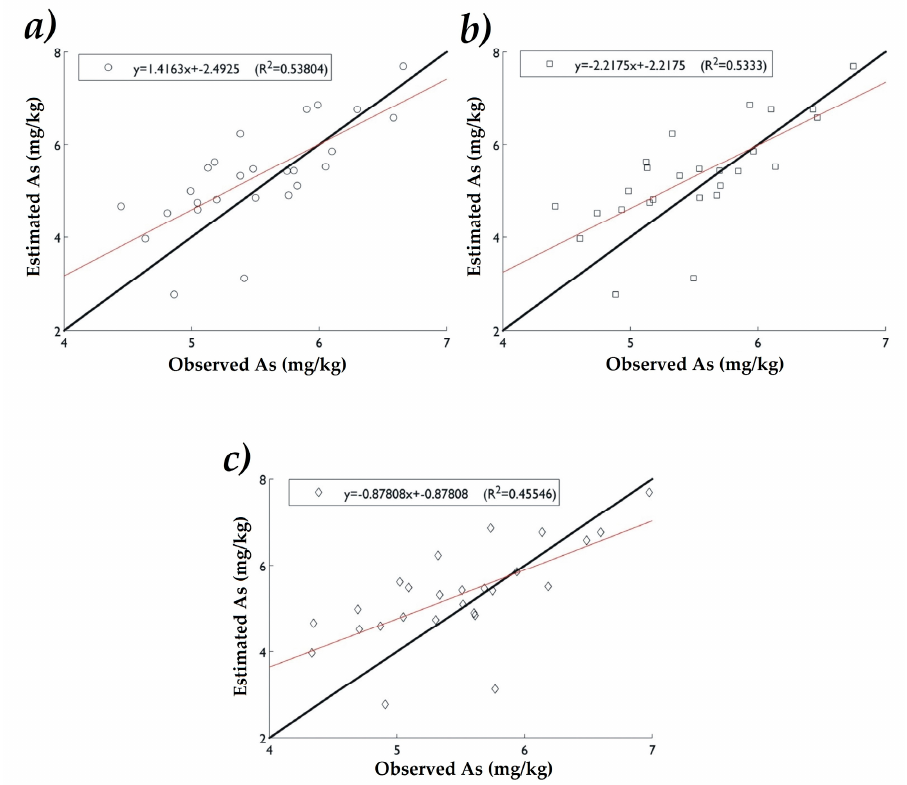
Figure 8. Correlation between experimental and estimated values of As(ln) in P1 by ( a ) IDW, ( b ) OK and ( c ) RBF.